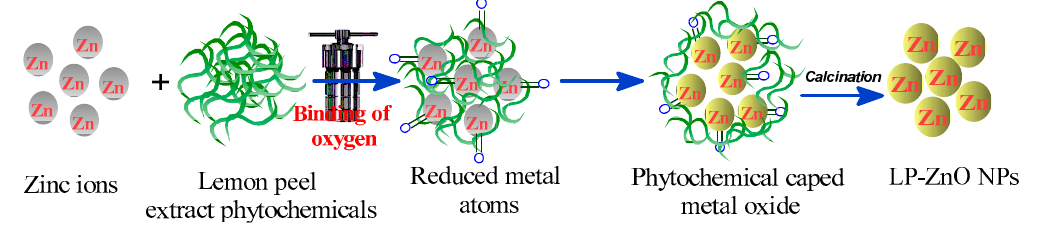
Figure 2. Possible mechanism of LP-ZnO NP formation using lemon peel aqueous extract.